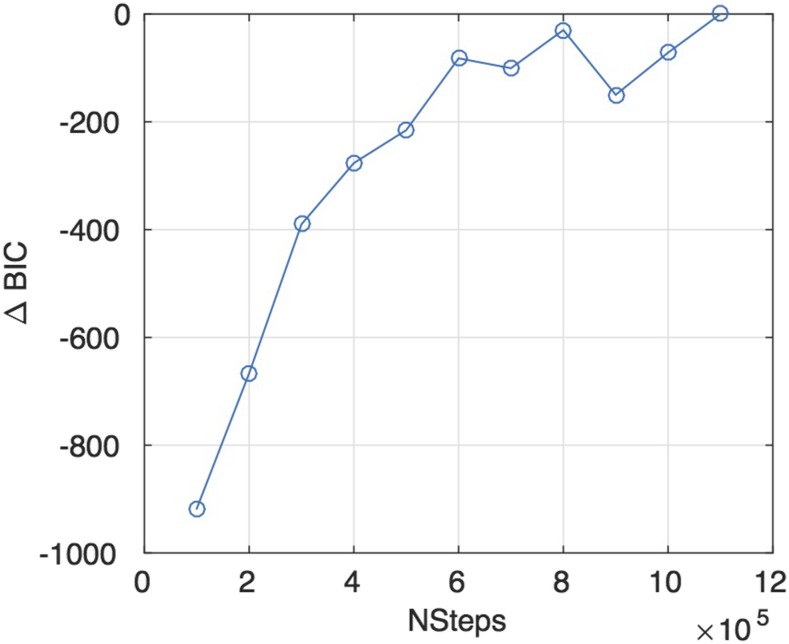
Convergence of ΔBIC (referenced from structure with 1.1M Nsteps) with NSteps (defined as number of steps during simulated annealing phase). Each value is the arithmetic mean over 5 independent structure runs.